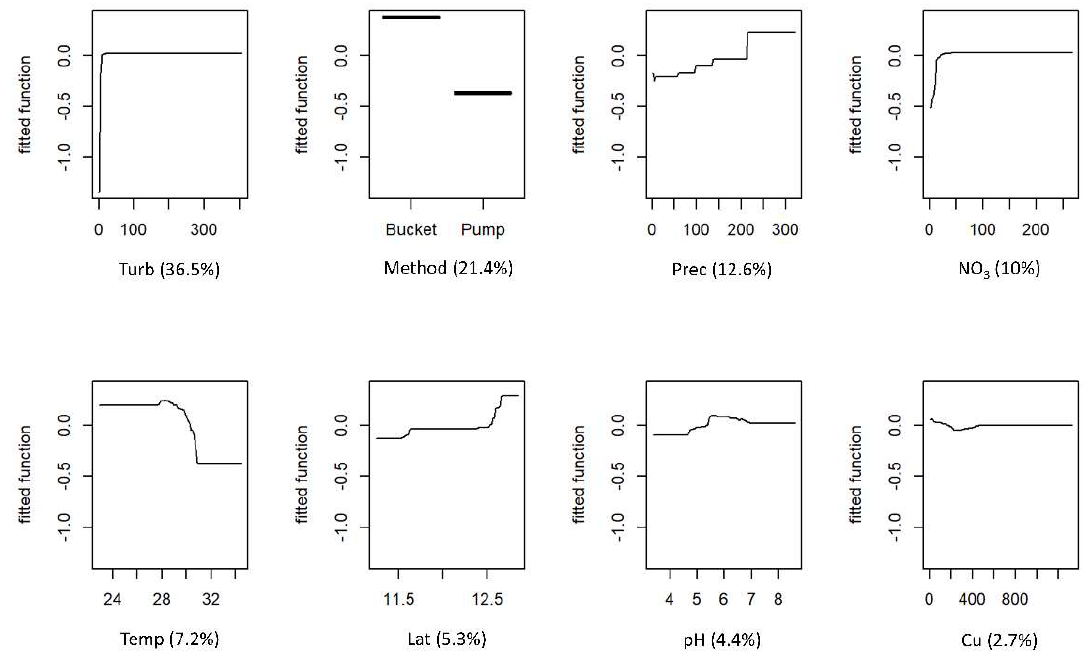
Figure 3. Boosted regression tree (BRT) partial dependence plots showing the effect of each predictor variable on faecal coliforms (FC) of the water of wells in Guinea-Bissau: Turb—turbidity; Method—method used for water collection; Prec—precipitation; NO 3 —nitrate; Temp—temperature; Lat—latitude; Cu—copper. At each plot, the fitted function shows the relationship between the response variable ( y −axis), and the predictor variable ( x −axis), holding the values of all other variables at their mean. The relative contribution (%) of each predictor variable for the BRT model is shown in brackets.